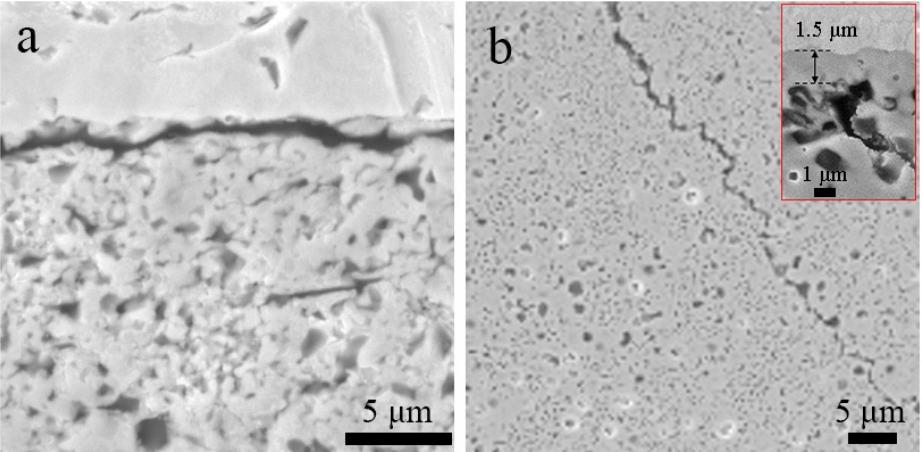
Figure 6. The cross-section image after TS test: ( a ) the fracture growth along interfacial layer after sintering at 150 °C; ( b ) the fracture extension crossing Ag nano paste matrix after sintering at 300